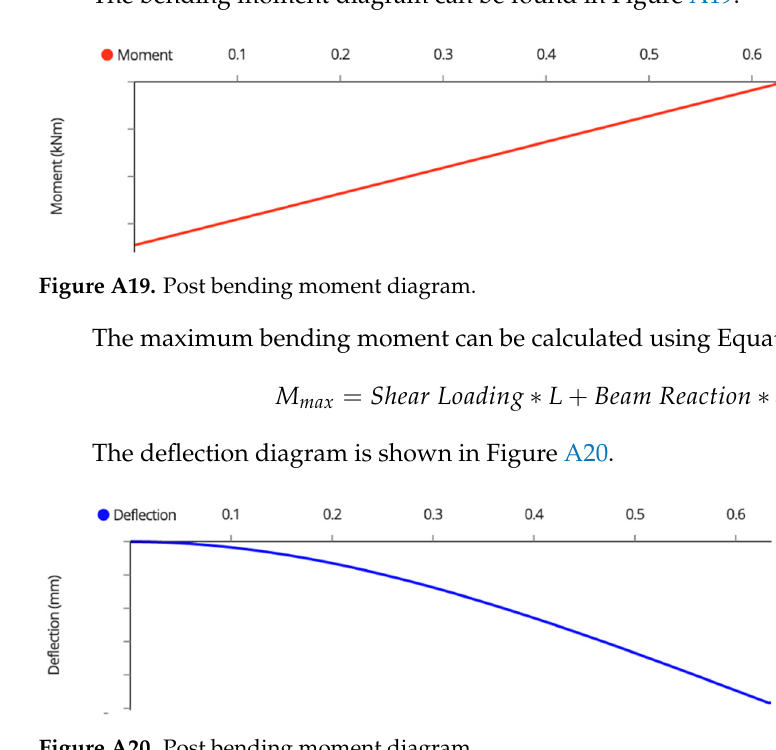
Figure A20. Post bending moment diagram.